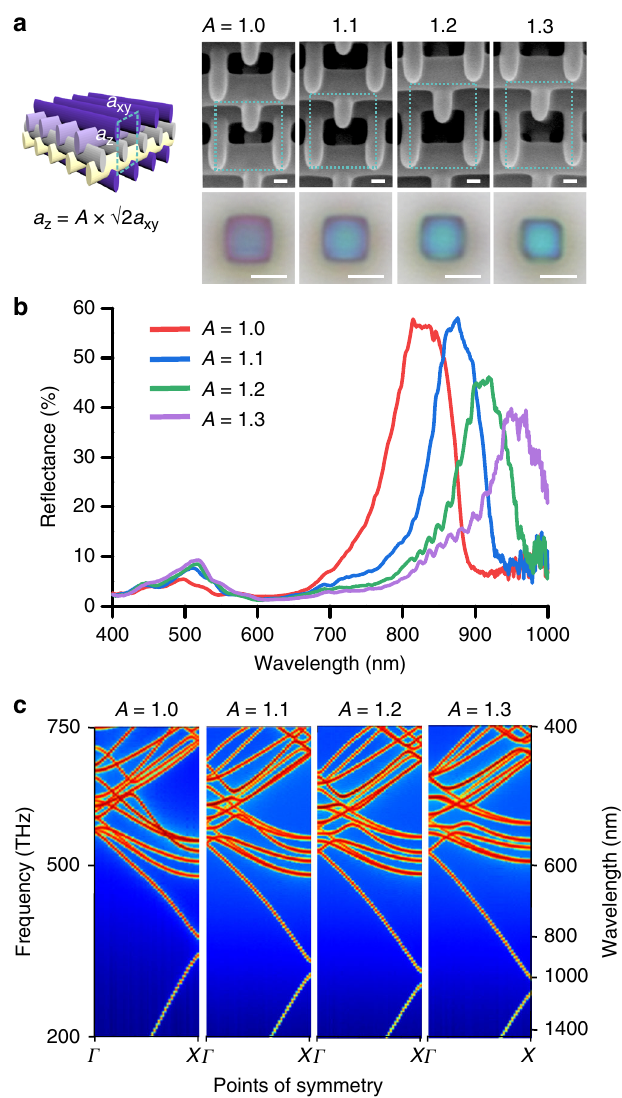
Fig. 3 Re fl ectances and bandstructures of woodpile structures with fi xed a = 450 nm and varying A , the scaling factor of a xy z . a 45 o -tilted-view SEM and re fl ection-mode micrographs of the woodpile photonic crystals with A varying from 1.0 to 1.3. SEM scale bars represent 100 nm and micrograph scale bars represent 5 µ m. b Top-down re fl ectance spectra of the woodpile photonic crystals. c Bandstructures in the Γ – X direction for A = 1.0 –